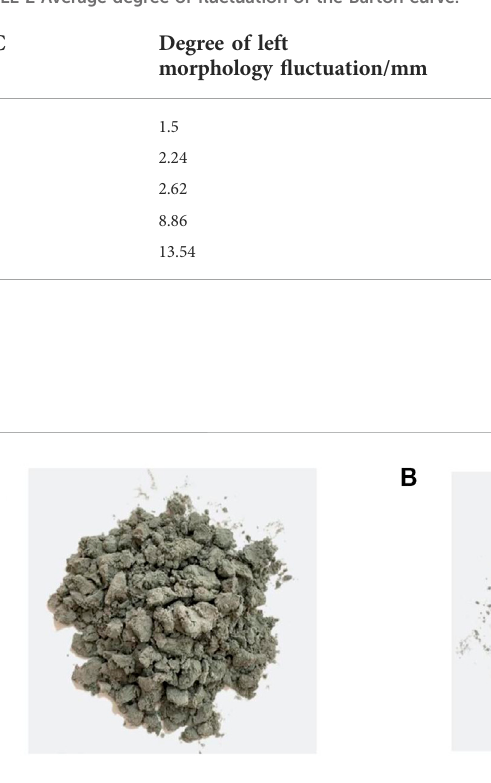
TABLE 2 Average degree of fl uctuation of the Barton curve.